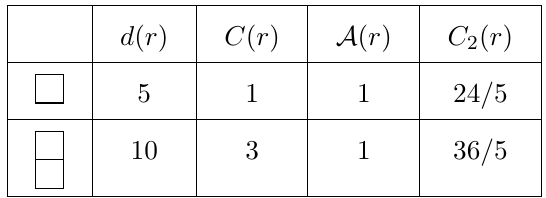
Table 5 . Properties for some representations of SU(5) .